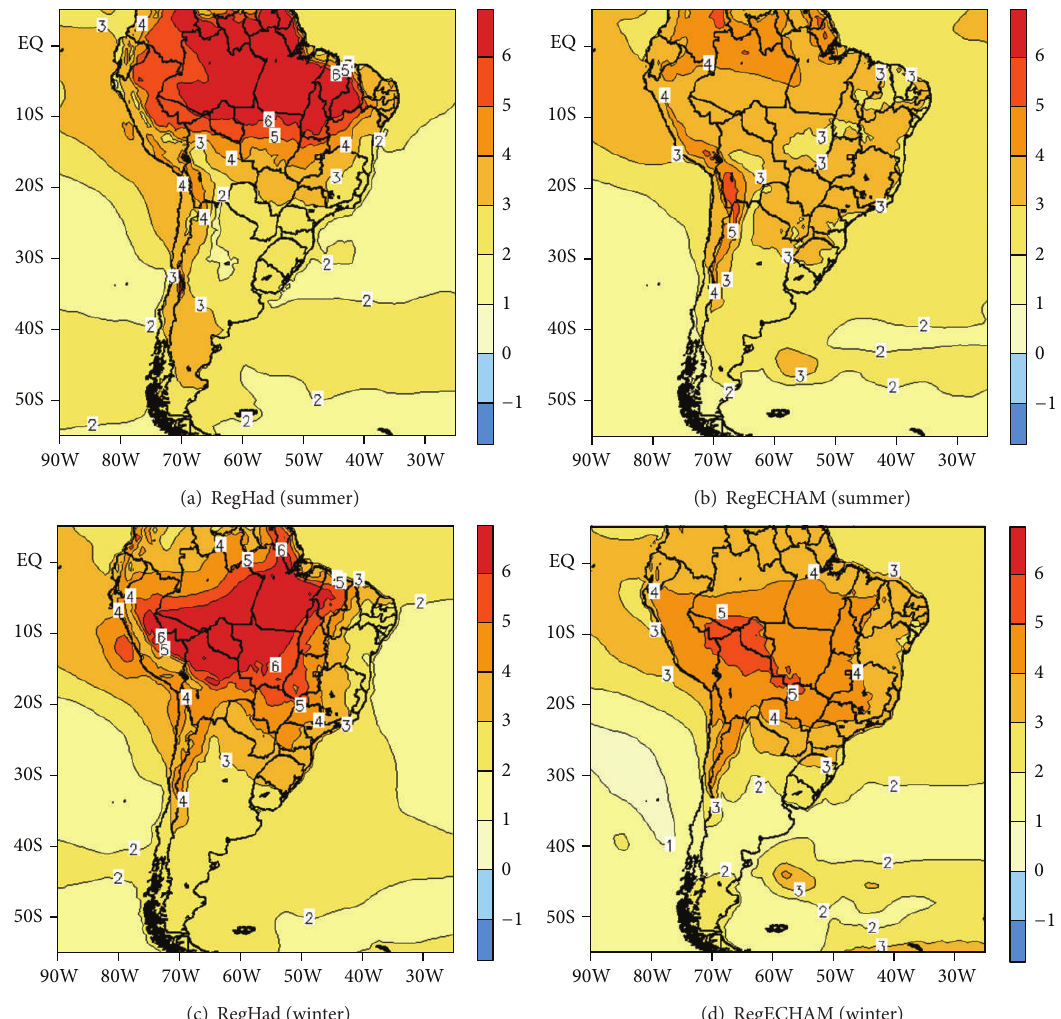
Figure 7: Similar to Figure 5, but in the far-future period (2070–2100 minus